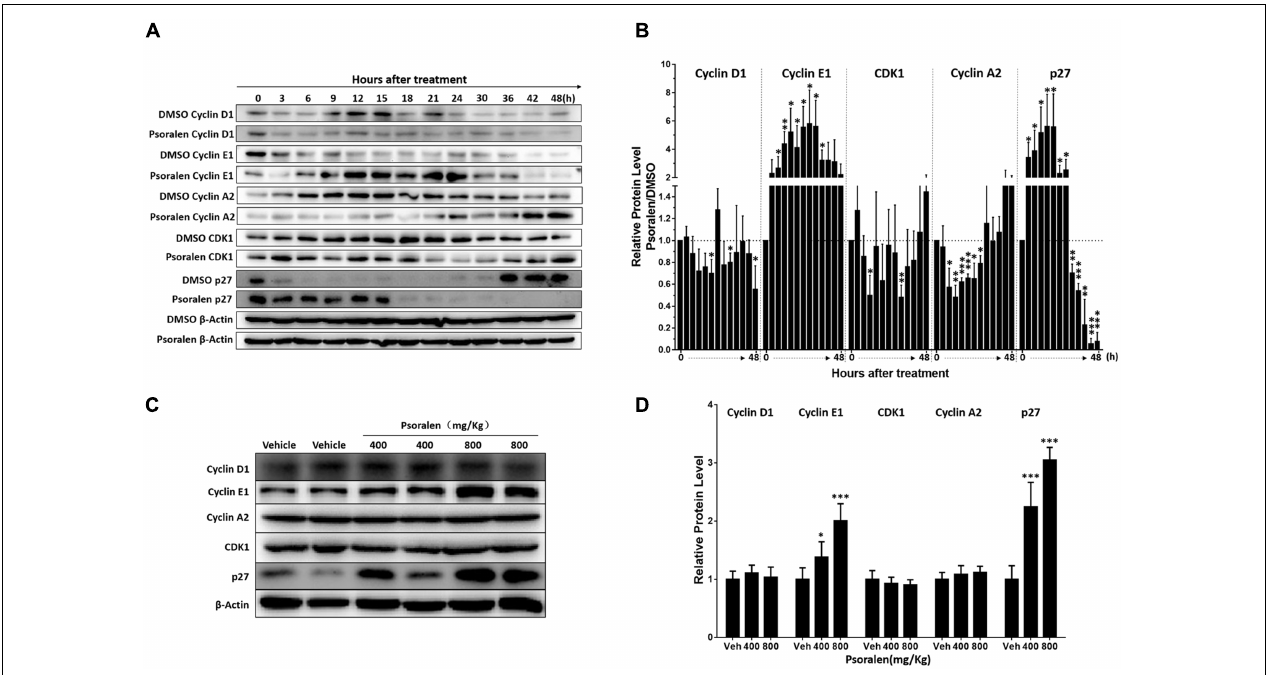
FIGURE 3 | Changes in cell cycle progression-related proteins after psoralen treatment in L02 cells and mice. L02 cells were treated with DMSO or psoralen and incubated for various time periods. When the cells were just beginning to completely adhere (defined as 0 h), the total protein was collected successively every 3 and 6 h during a 48 h period. All experiments were performed three times independently. (A) Representative immunoblots for the protein levels of cyclin D1, cyclin E1, cyclin A2, CDK1, and p27. (B) Relative protein levels of cyclin D1, cyclin E1, cyclin A2, CDK1, and p27. The density of immunoreactive bands was quantified using ImageJ software. Density values were normalised to β -actin and then expressed as the relative expression levels between DMSO-treated and psoralen-treated. C57BL/6 mice were treated with 0.5% CMC-Na solution (vehicle group), or 400 mg/kg or 800 mg/kg psoralen for 24 h. (C) Representative immunoblots for the protein levels of cyclin D1, cyclin E1, cyclin A2, CDK1, and p27. (D) The correspondingly relative protein levels were quantified by scanning band intensity and normalised to β -actin ( n = 6). Data are means ± SDs ( n = 6). ∗ p < 0.05, ∗∗ p < 0.01, ∗∗∗ p < 0.001 versus DMSO group or vehicle group.